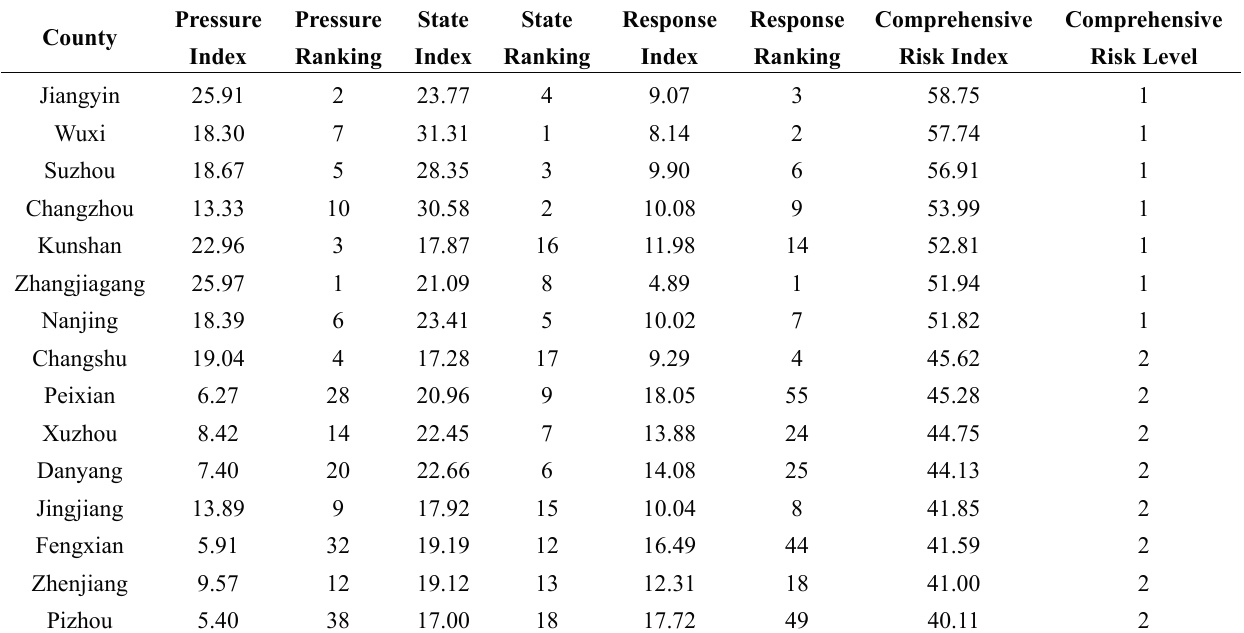
Table 3. Counties with environment and health comprehensive risk at level 1 and